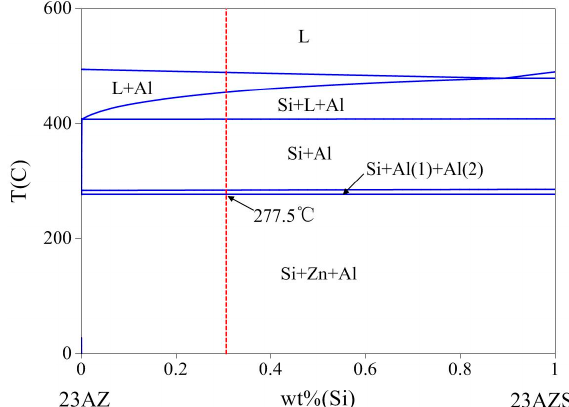
Figure 3. Vertical section phase diagram of 23AlZn and 23AlZn1Si (wt %).